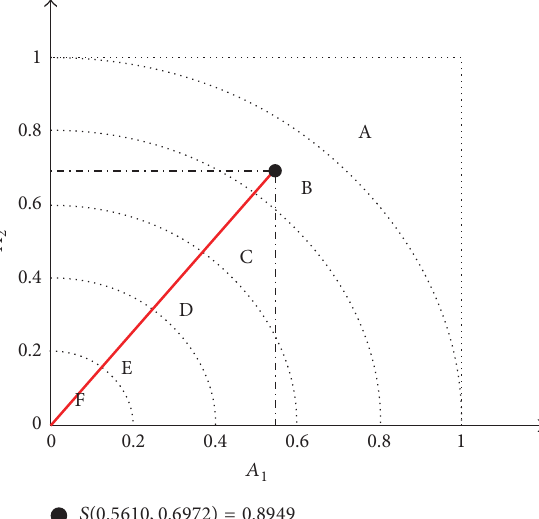
Figure 10: Combined annoyance degree of vibration and ambient noise at E0.